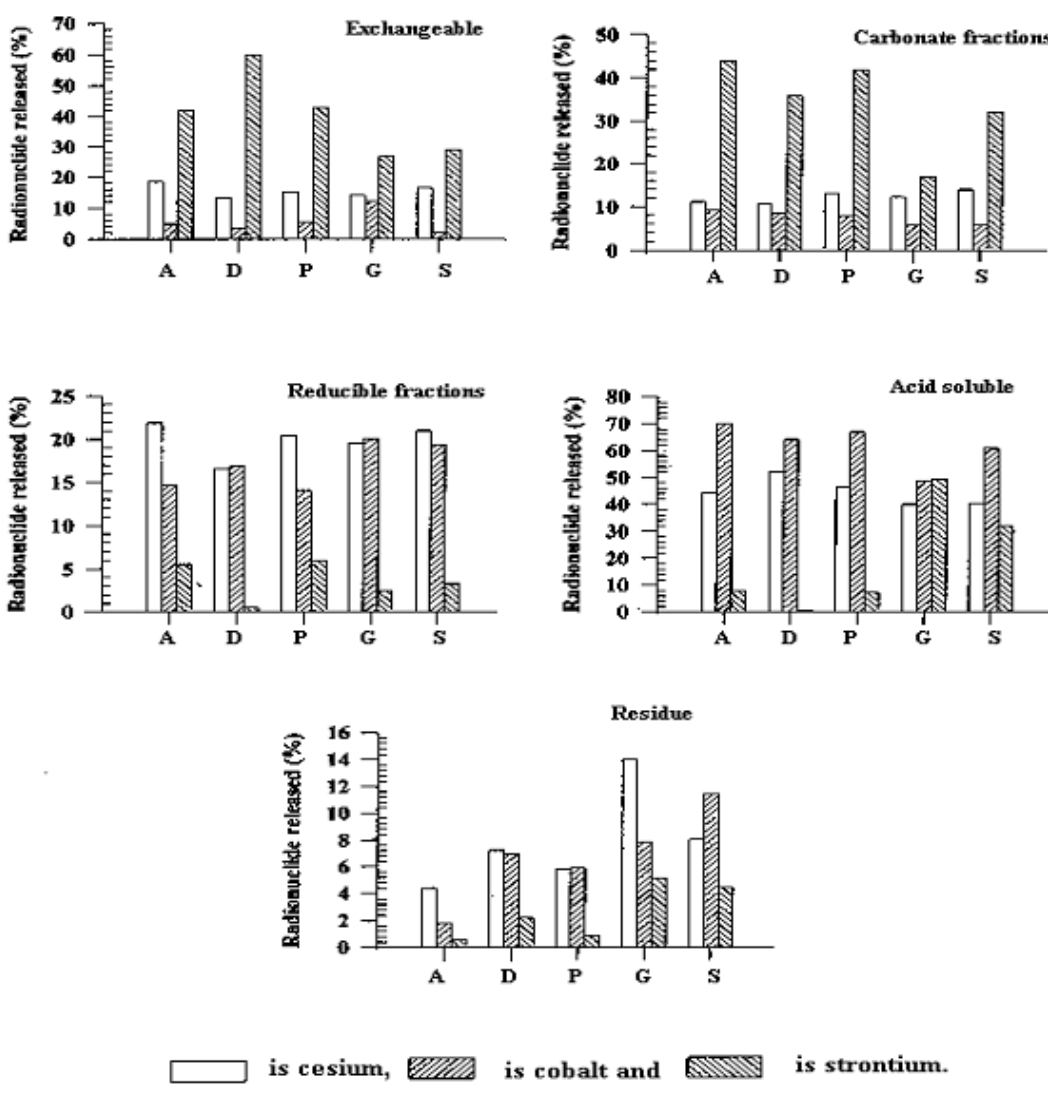
FIGURE 4 . 134 Cs, 60 Co, and 85 Sr radionuclides released percentage by different sequential extractions for the following: exchangeable, carbonates, reducible, acid soluble, and the residue (see legend): open box = cesium, ///// box = cobalt, \\\\\ box = strontium. A, D, P, G, and S are the Sample Code of Agami, Dameitta, Port Said, Gamasa, and Sharm